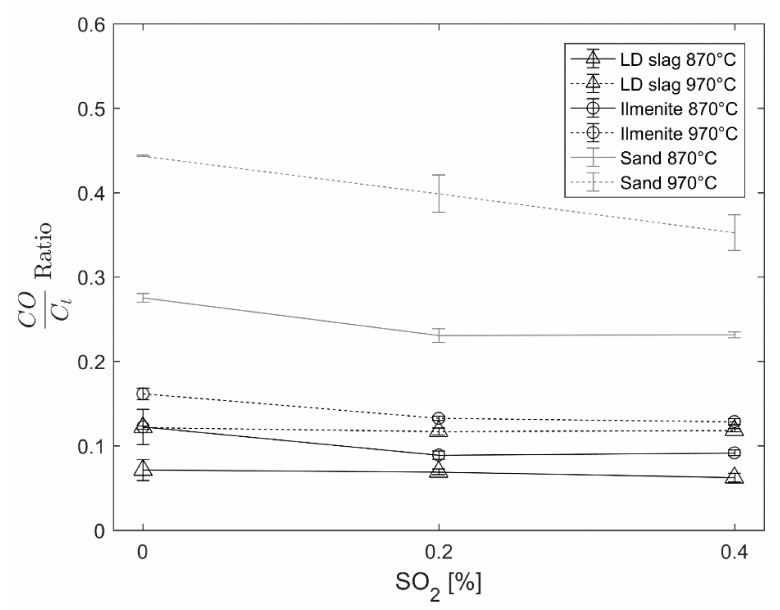
Figure 9. Molar CO ratio over total outgoing carbon for the gasification experiments, taken between 0.3 < X c < 0.7 for LD slag, ilmenite, and sand at 870 ◦ C and 970 ◦ C using devolatilized wood pellets as